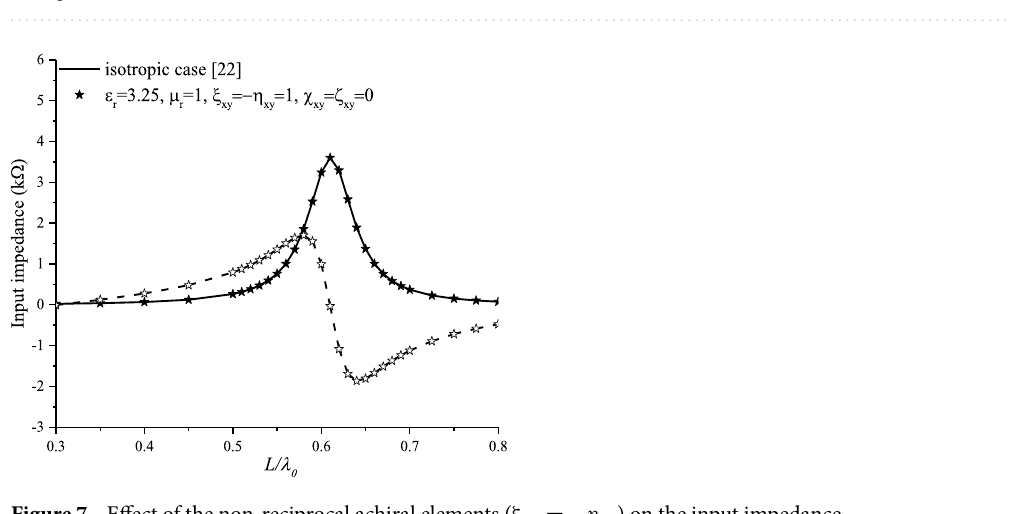
Figure 7. Effect of the non-reciprocal achiral elements ( ξ xy